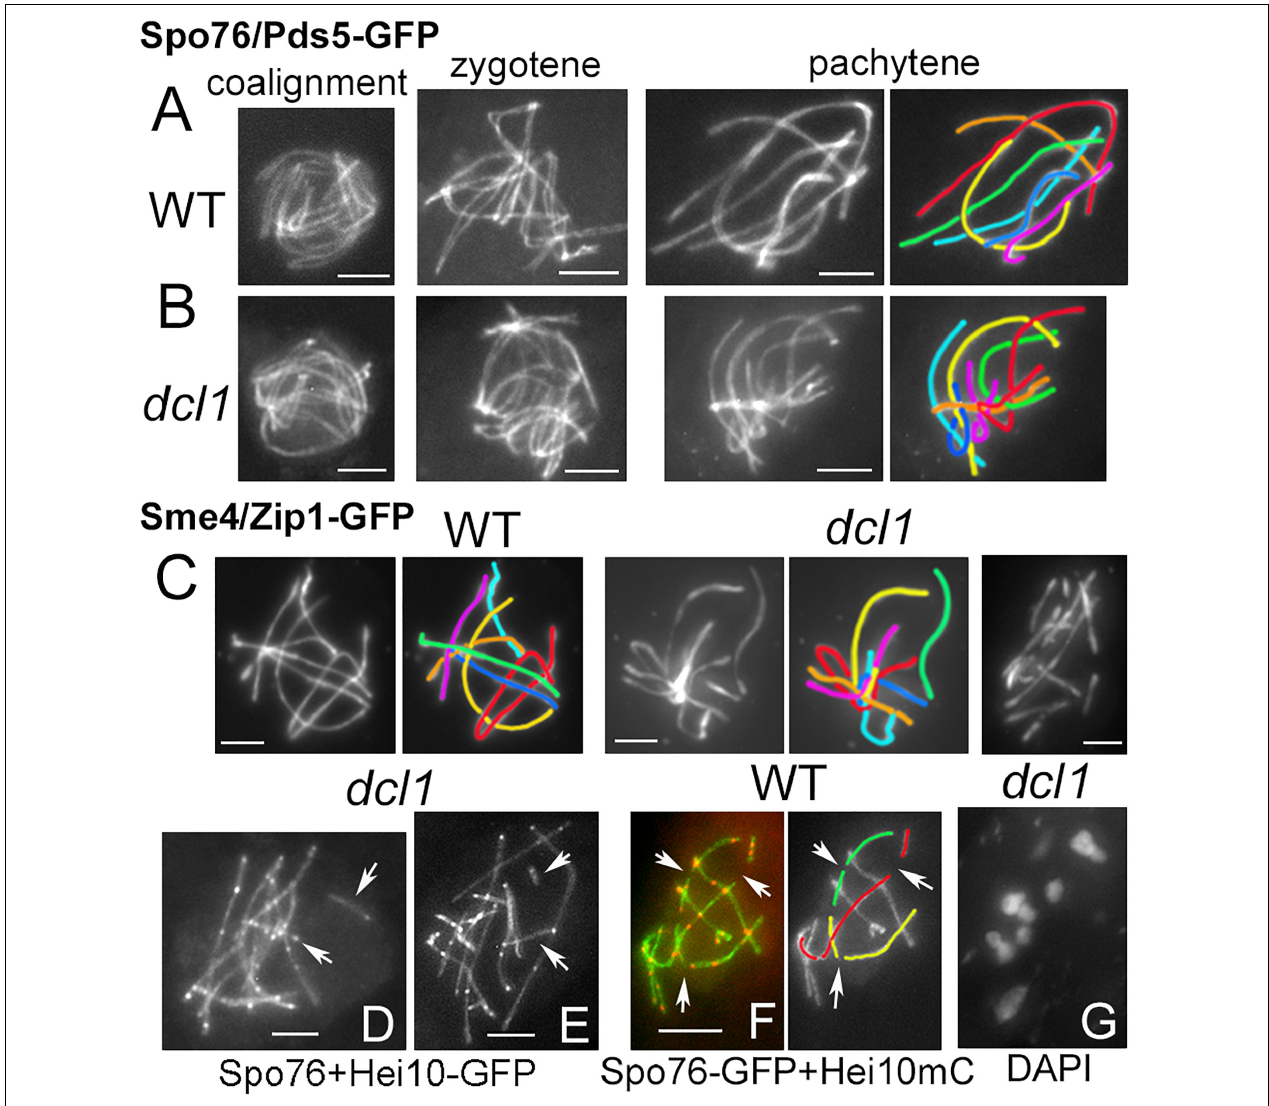
FIGURE 2 | Synaptonemal complex in wild type and dcl1 . (A,B) Chromosome axes are marked by Spo76/Pds5-GFP. From left to right: progression from coalignment at late leptotene, partial synapsis at zygotene (middle) and complete synapsis at pachytene in wild type (A) and dcl1 (B) ; the seven homologs are distinguishable by their lengths and colors. (C) SCs are marked by the central component Sme4/Zip1-GFP in wild type (left) and in dcl1 with full SC along all homologs (middle). Right: example of a dcl1 pachytene nucleus with more than 7 SCs. (D,E) Two dcl1 nuclei with extra SC segments (arrows), either separated from the other SCs (upper arrows), or at odd angles (lower arrows). (F) Interrupted SCs are also seen in WT late pachytene nuclei (arrows), but the SC paths can be followed in the concerned homologs (illustrated for three of them, right). (G) Diplotene of dcl1 with 7 bivalents. Bars, 2 µ